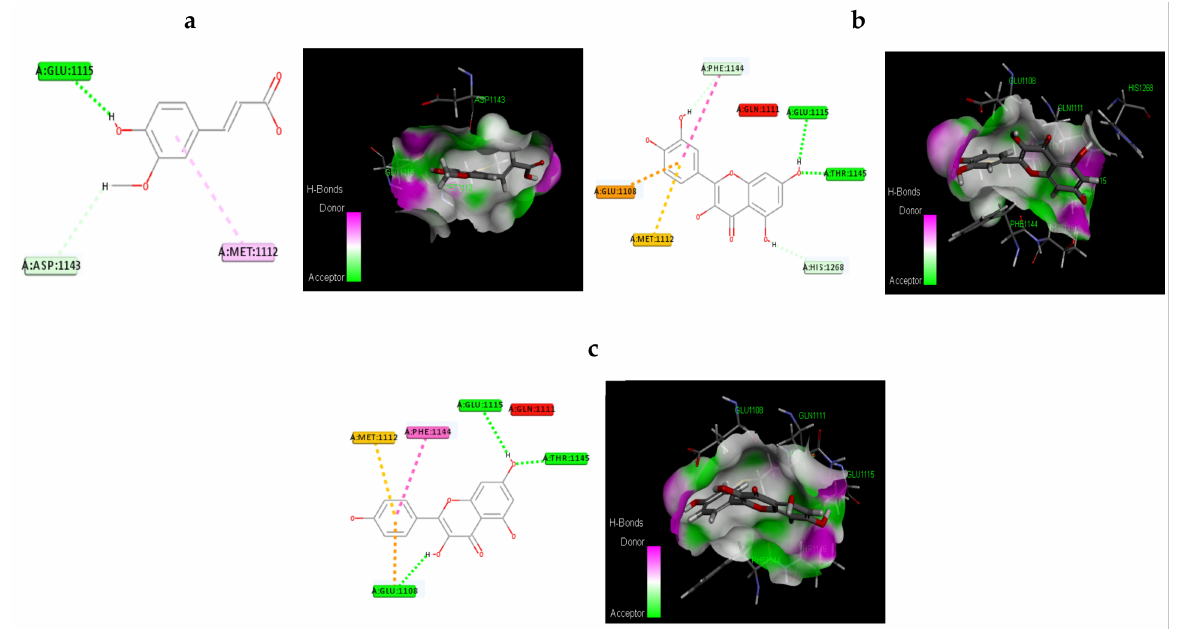
Figure 11. Molecular interaction of the best three compounds with IR: ( a ) Trans-Ferulic Acid, ( b ) Quercetin, and ( c ) Kaempferol.